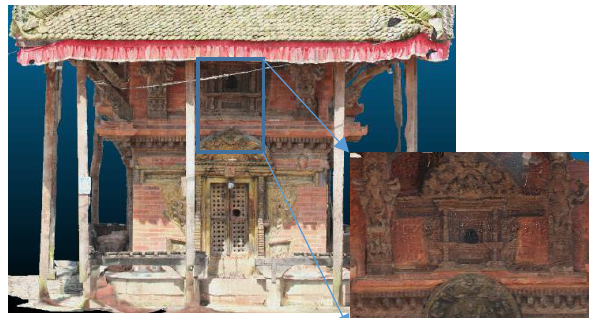
Figure 8. 3D model of a typical Hindu temple in Nepal. Areas covered by the roof are poorly